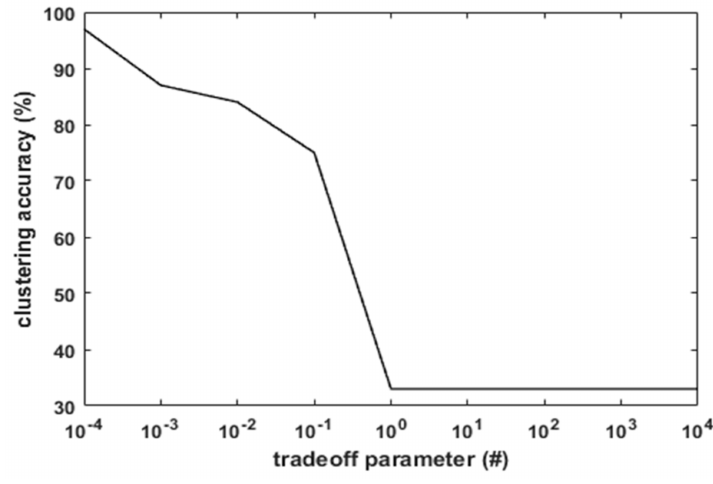
Figure 6. Clustering accuracy versus tradeoff parameter λ